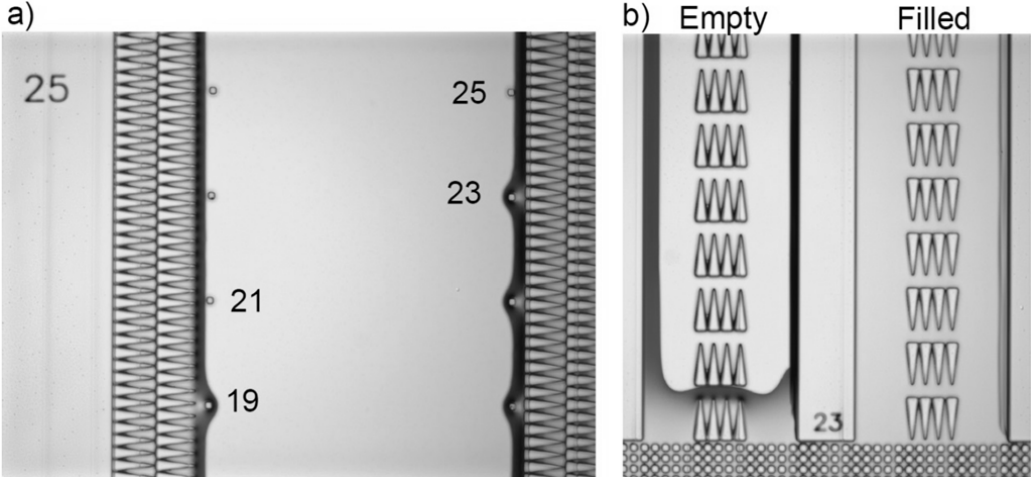
Figure 7. Directional wetting test of ORMOCOMP ® microstructures. ( a ) Reach measurement of the liquid meniscus from the tips and bases of the triangles. The reach from bases is 24 ± 1 μm ( right side) while the reach from the tips is 20 ± 1 μm ( left side); ( b ) Directional wetting is achieved by spacing the pillars 20–24 μm apart. The spacing presented here is 23 µm and the channel on the right is completely filled. In contrast the channel on the left has only filled at the corners and the first pillar row which is in contact with the reservoir while the main channel remains